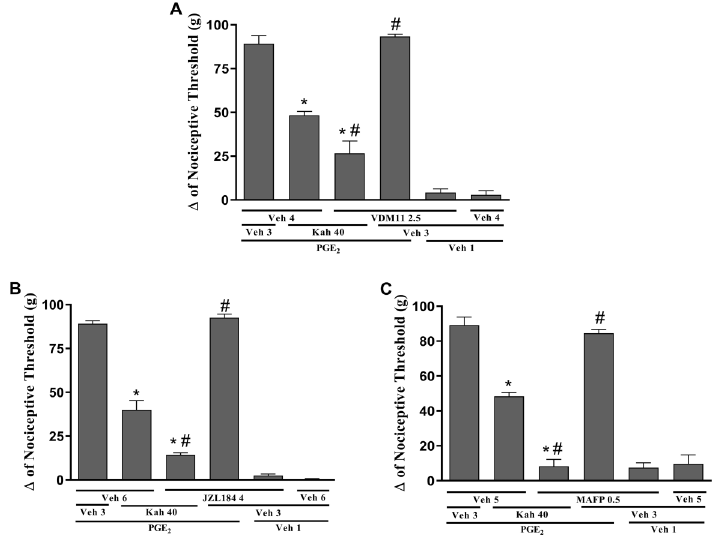
Figure 5. Pretreatment with VDM11, JZL184, and MAFP potentiated the peripheral antinociceptive action of kahweol. The antinociceptive response was measured by the paw pressure test. Prostaglandin E 2 (PGE 2 ) injection (2 m g/paw) was done at time 0. VDM11 (2.5 m g/paw; A ), JZL184 (4 m g/paw; B ), or MAFP (0.5 m g/paw; C ) was injected at time 165 min, and kahweol (Kah; 80 m g/paw) was given at 175 min. Measurements were made prior to and 180 min after PGE 2 administration. Data are reported as means ± SE (n=5) of D nociceptive threshold measured in grams (g). *P o 0.05 compared to (PGE 2 + Veh 3 + Veh 4/Veh 5/Veh 6); # P o 0.05 compared to (PGE 2 + Kah 80 + Veh 4/Veh 5/Veh 6)-injected groups (ANOVA and Bonferroni ’ s test). Veh (vehicle) 1: 2% ethanol in saline; Veh 3: sterile saline solution (0.9% NaCl); Veh 4: 10% tocrisolve in saline; Veh 5: 3% ethanol in saline; Veh 6: 20% DMSO in saline.